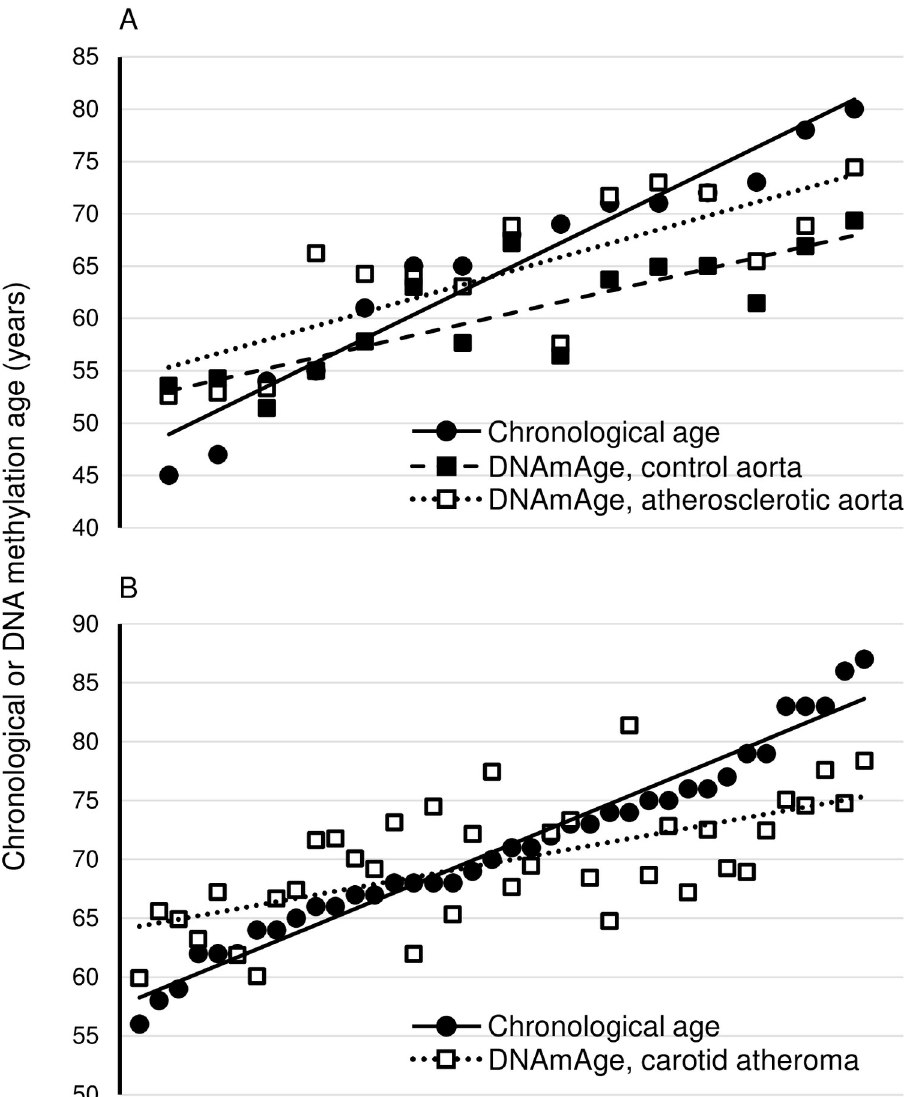
Fig 1. Chronological and Horvath DNA methylation age in aortas and carotid atheromas. Samples are ordered by increasing chronological age (reported on the y-axis) and positioned at regular intervals on the x-dimension. A, donor- matched atherosclerotic and histologically normal portions of the aorta; B, carotid atheromas. Interpolating lines are not regression slopes, rather are intended to convey differences in ageing pace. Notice the tendency for accelerated and decelerated DNA methylation age at early and later ages,